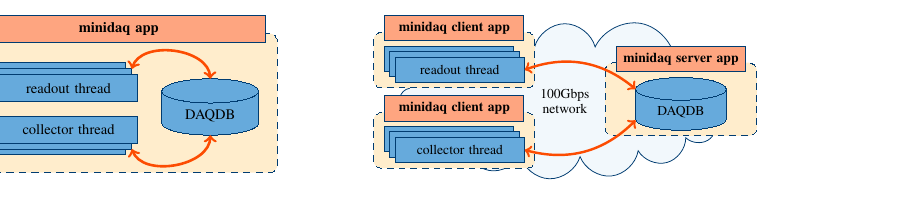
Figure 1. Single-node configuration. Figure 2. Multi-node